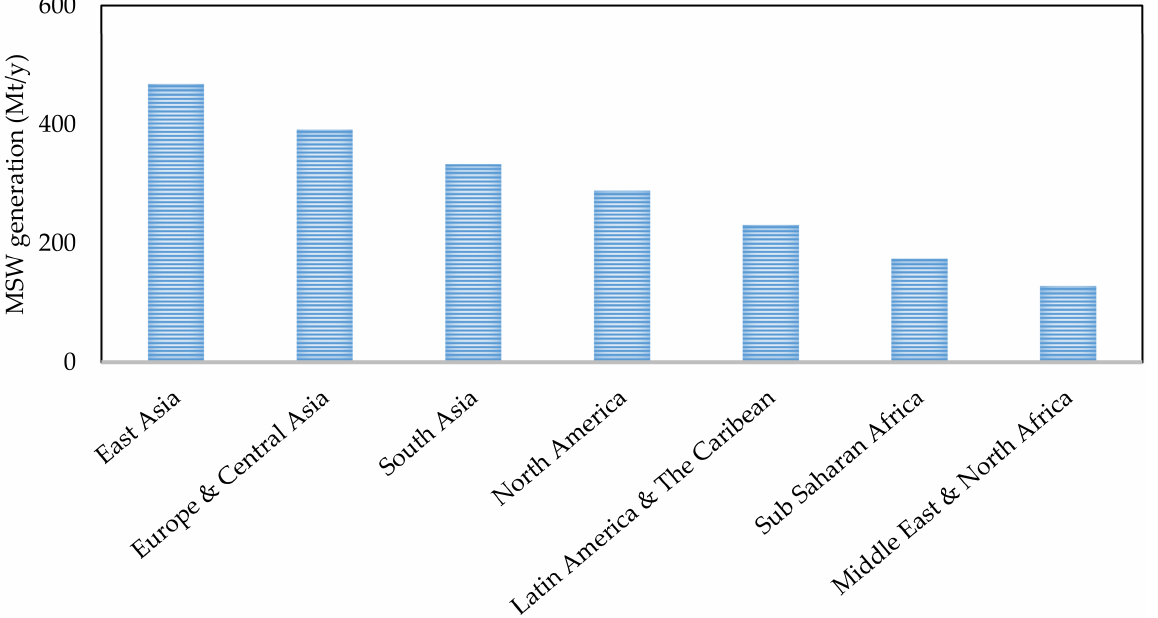
Figure 1. Worldwide annual regional waste generation according to World Bank,